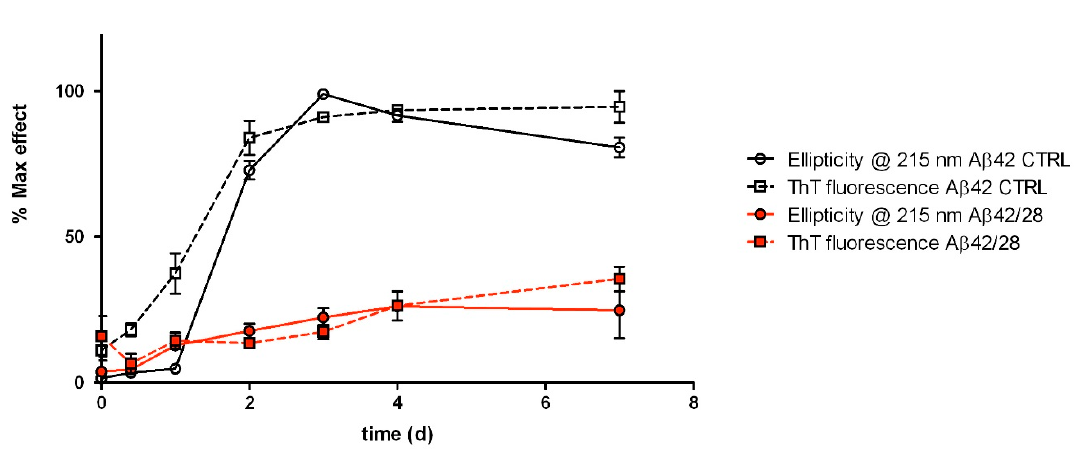
Figure 4. Time-course aggregation kinetics of 50 µ M A β 42 control (black lines) and A β 42 with 20 µ M 28 (red lines). Results are expressed as percentage of the maximal values of CD ellipticity at 215 nm (circles, full lines) and ThT fluorescence (squares, dotted lines) of control peptide sample.